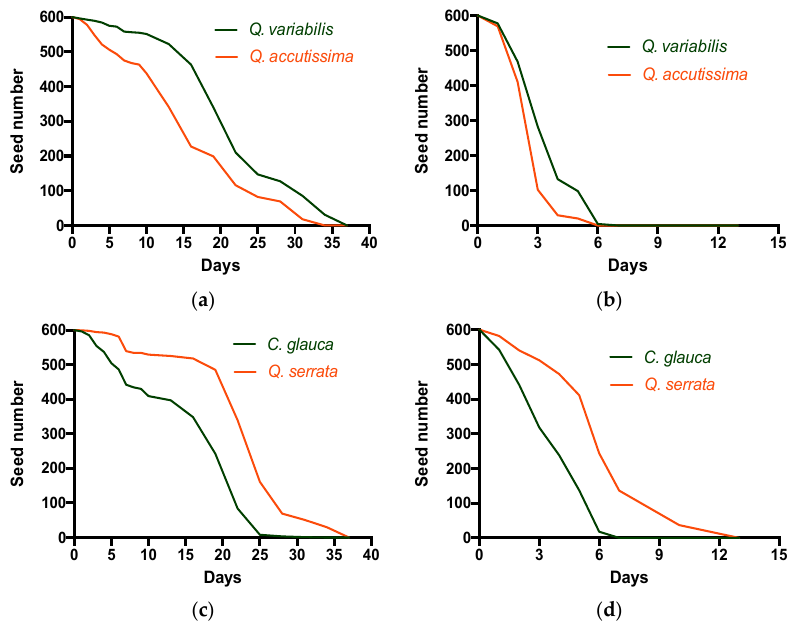
Figure 2. Field acorn removal of Q. variabilis and Q. accutissima ( a , b ), and Q. serrata and C. glauca ( c , d ) in the non-masting year.